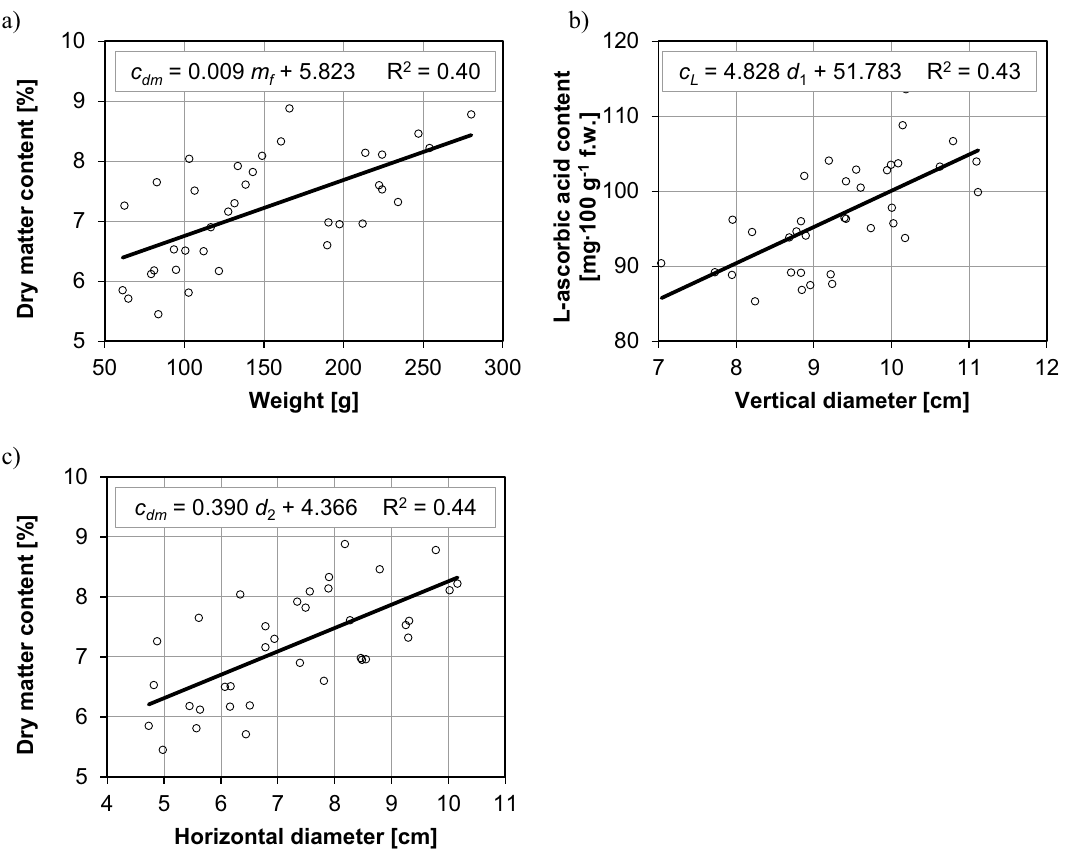
Figure 2. Relationships between the biometric parameters and chemical composition of fruit in sweet cultivars of Capsicum annuum : ( a ) weight and dry matter content, ( b ) vertical diameter and L-ascorbic acid content, ( c ) horizontal diameter and dry matter